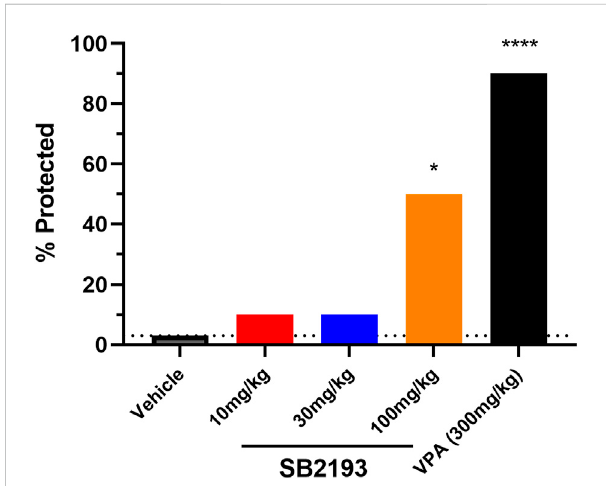
FIGURE 7 SB2193 treatment in Swiss mice administered 6 Hz corneal stimulation. Percentage of Swiss mice protected from seizure in the 6 Hzseizure modelfollowingacute treatment withSB2193or valproic acid ( n = 10 per group). Drugs were administered via intraperitoneal injection. SB2193 (100 mg/kg) increased the percentage of mice protected ( χ 2 = 6.33, p = 0.01) as did valproic acid (300 mg/kg) ( χ 2 = 15.54, p < 0.001) (* p < 0.05, **** p ≤